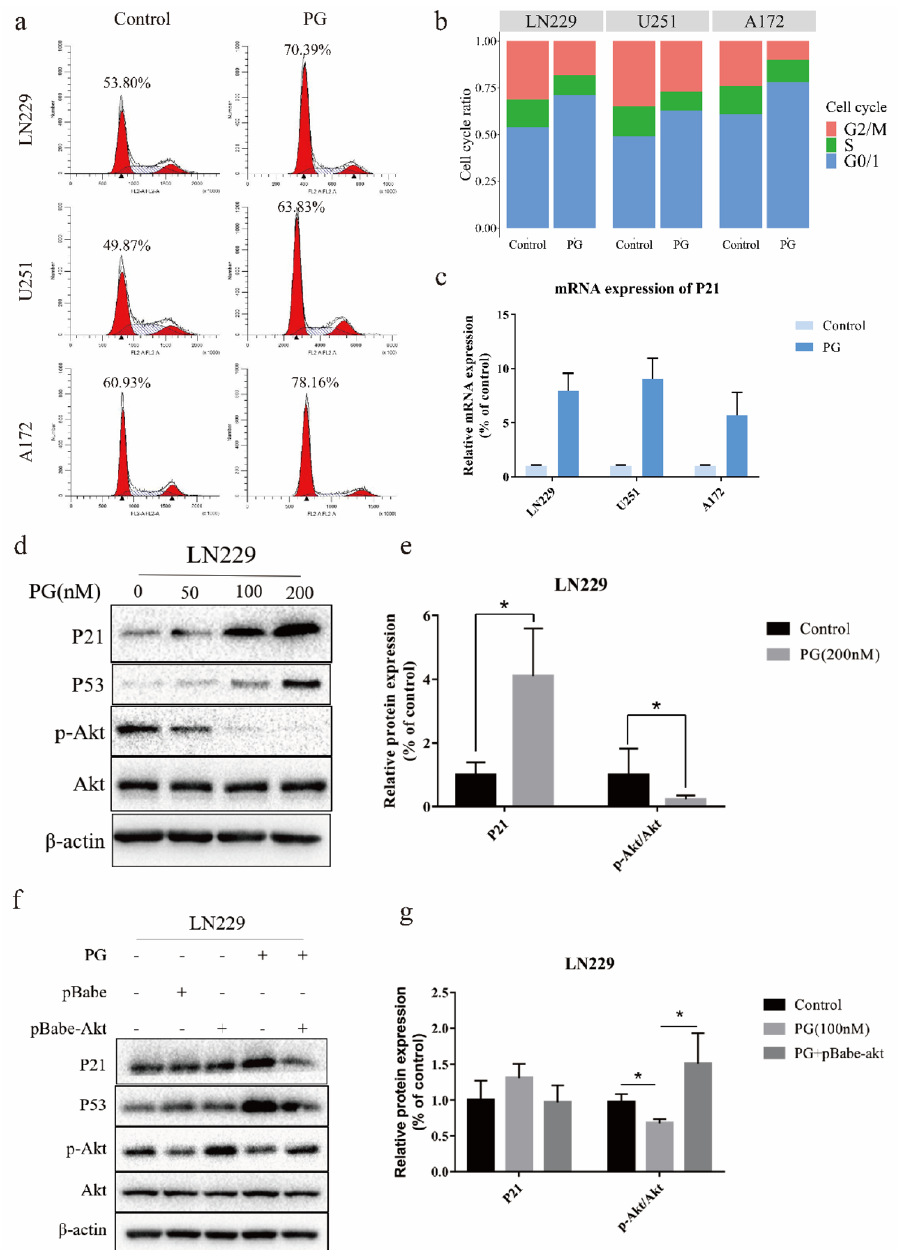
Figure 2. PG induced cell cycle arrest by inhibiting the phosphorylation of Akt ( a ) Cell cycle analysis of A172, LN229 and U251 cells by flow cytometry. All cells were exposed to 0 or 200 nM PG for 48 h. ( b ) Statistical data of cell cycle assay. All experiments were repeated three times. ( c )The mRNA level of P21 was analyzed by RT-PCR. Data were expressed as the means ± SD. ( d ) The protein levels of P21, P53, p-Akt (S473), Akt and β-actin in LN229 cells treated with PG. Human β-actin was used as a reference gene. Experiments were performed three times. ( e ) Graphic representation of relative levels of protein expression in LN229 cells treated with PG. Data are expressed as the means ± SD. p < 0.05. ( f ) Western blotting analysis of the target proteins in LN229 cells expressing p-Akt or vector in the presence or absence of PG (100 nM) for 48 h. Experiments were performed three times. ( g ) Graphic representation of relative levels of protein expression in LN229 cells treated with PG with or without pBabe-Akt. Data are expressed as the means ± SD. p <